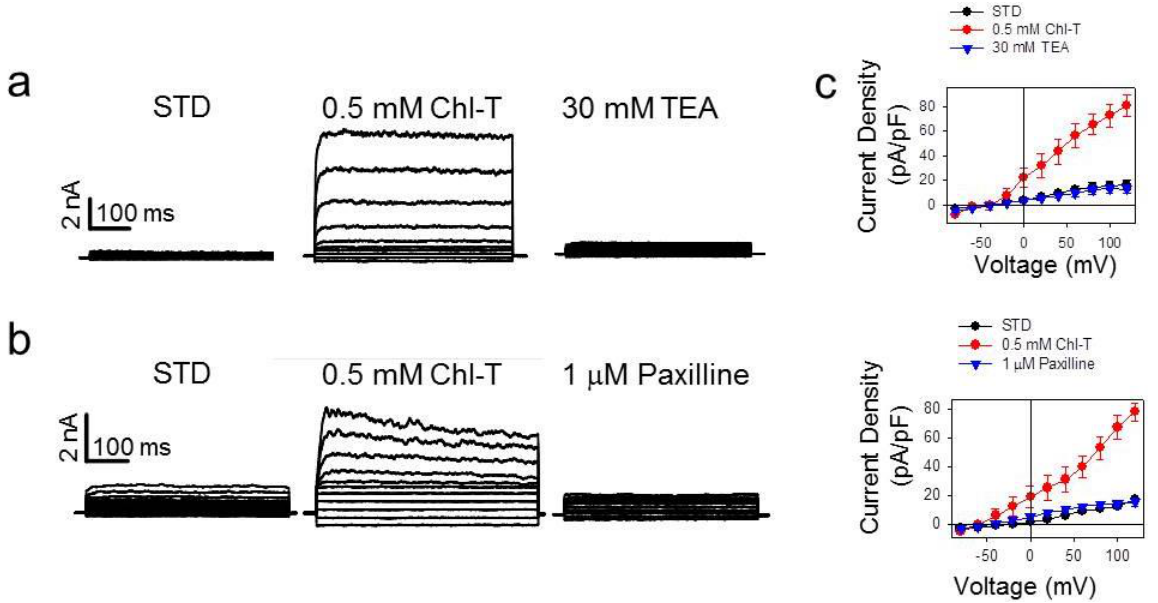
Figure 3. BK current activation by Chl-T oxidation in IGR39 cells. ( a ) Currents in a typical IGR39 cell elicited in STD solution (left) and after addition of 0.5 mM Chl-T (middle). Chl-T-evoked currents were blocked by 30 mM TEA (right traces). Average block at 100 mV: 81.9 ± 3.7% ( p = 0.017, n = 8). ( b ) Representative currents recorded from another IGR39 cell. The potassium current, stimulated by oxidation, was blocked at positive voltages by 1 µM paxilline (right panel). Average block at 100 mV: 79.0 ± 2.5% ( p = 0.0062, n = 6). ( c ) Average current density–voltage relationships for IGR39 cells treated with Chl-T and 30 mM TEA (top panel) and Chl-T and 1 µM paxilline (bottom). Data are expressed as mean ± SEM from 6 experiments each.